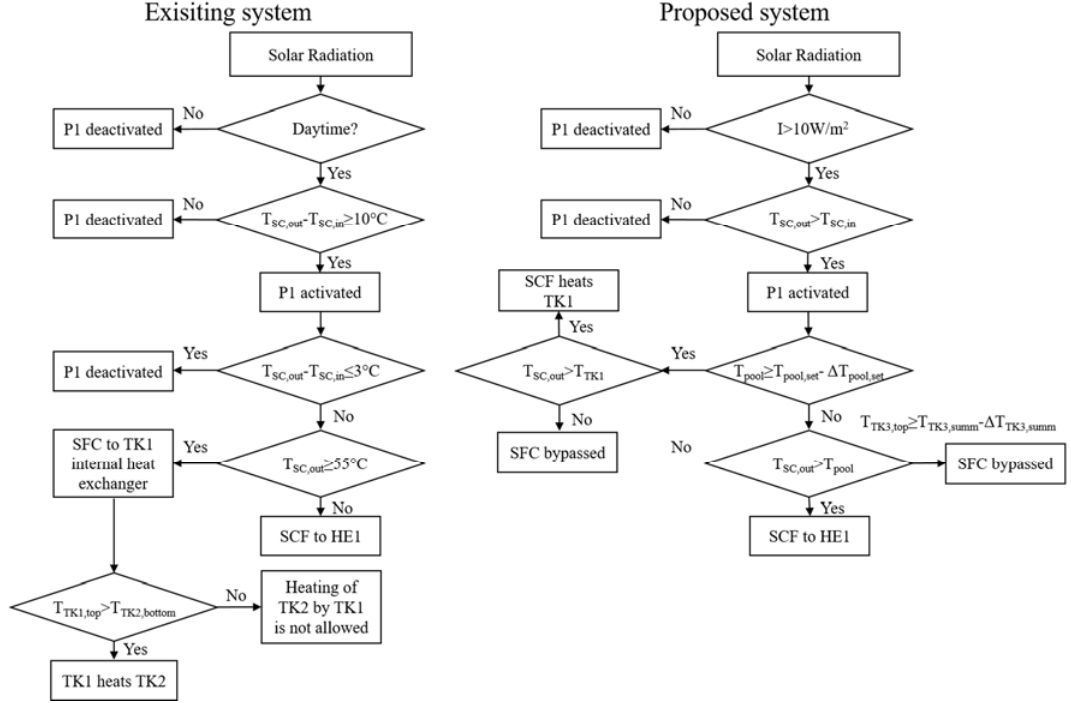
Figure 4. Solar loop control strategy of the existing ( left ) and proposed ( right ) system. Table 1. Attendance of the swimming pool users.